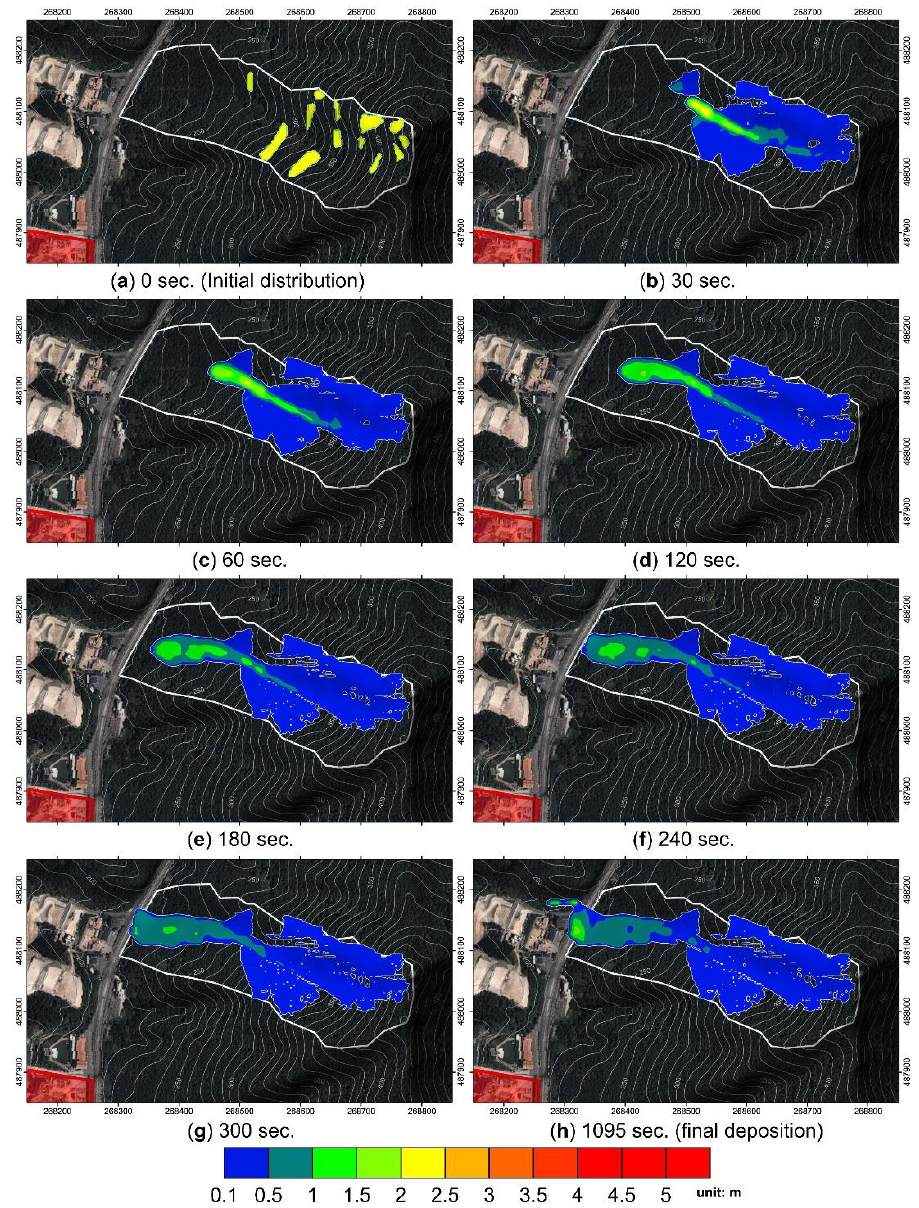
Figure 11. Simulated flow and thicknesses of debris at different times (( a )~( h )) in Watershed A. ( a ) and ( h ) represent the initial and final (at 1095 s) distributions.